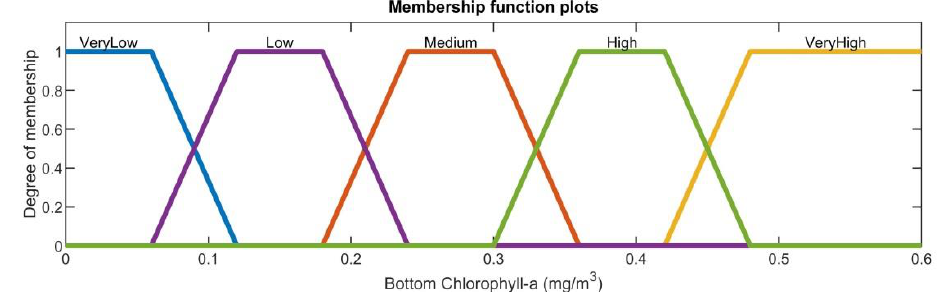
Figure 2. Trapezoidal membership functions for the fuzzy sets of Bottom Chlorophyll-a imported in the FIS.